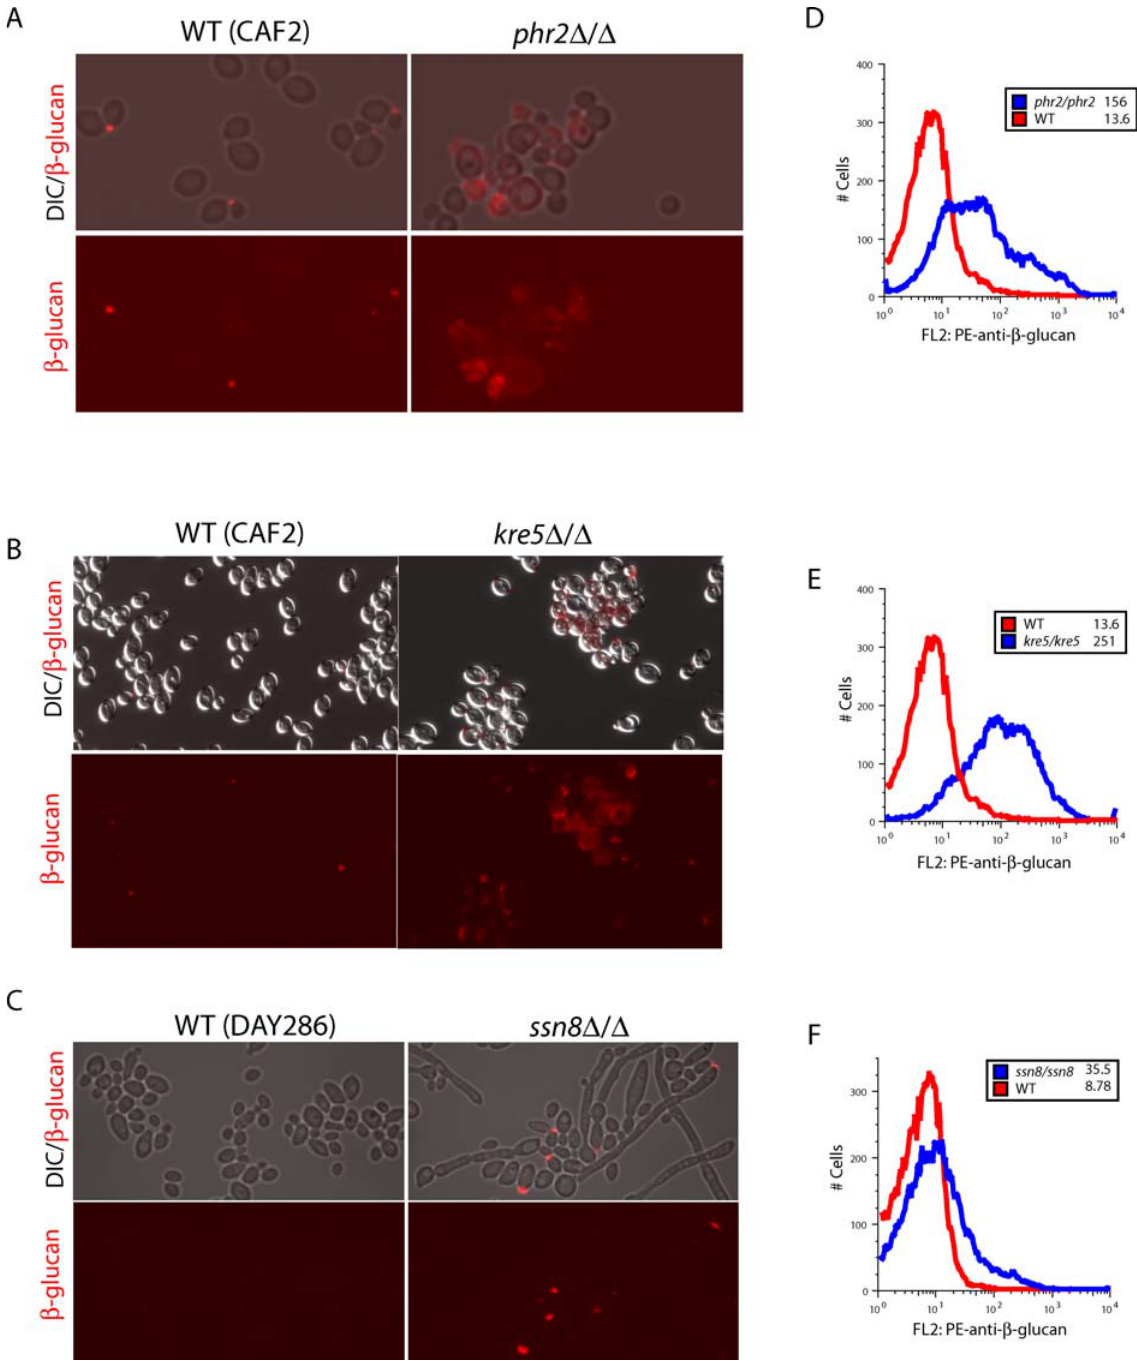
Figure 5. C. albicans Mutants of Masking Genes Have More Exposed b -Glucan Wild-type or mutant C. albicans strains were grown overnight in YPD, then stained with anti- b -glucan antibody and Cy3-labeled (A–C) or PE-labeled (D– F) secondary antibody. (A–C) Upper photomicrographs show overlay of brightfield and anti- b -glucan staining of Cy3-labeled cells; lower photomicrographs show anti- b -glucan staining alone. (D–F) Overlay histograms of FACS analysis of PE-labeled cells; data on 20,000 cells are shown. MFI values for wild-type and mutants are shown in insets. In parallel experiments, strains that were complemented with a wild-type copy of the gene showed full reversal of b -glucan exposure (for KRE5 ) or partial reduction in exposure (for PHR2 ) (Figure S5). This correlates with other phenotypes observed for these complemented strains [17,20,35]. DOI: 10.1371/journal.ppat.0020035.g005